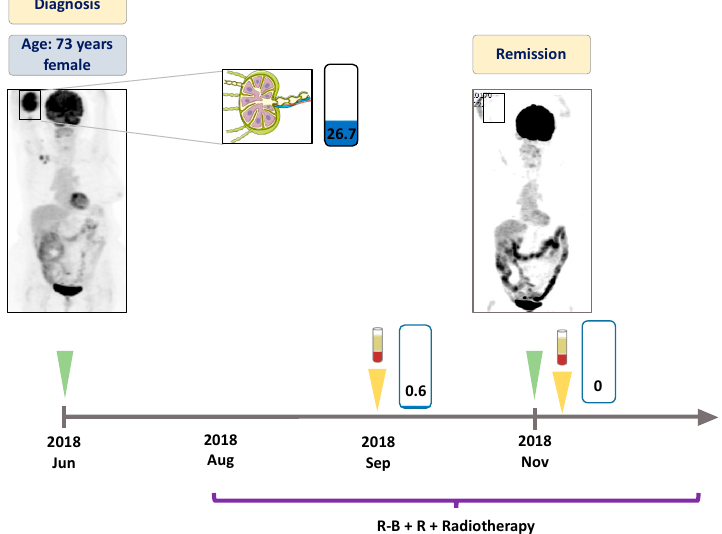
Figure 4. Detailed illustration of treatment monitoring in Patient #4. Low variant allele frequency of EZH2 Y646F mutation was found in the plasma after one week of treatment initiation. End of treatment ctDNA at three months was found to be EZH2 wild type, with the corresponding PET-CT revealing complete metabolic response of the disease. Since then the patient has received rituximab maintenance therapy with good general health conditions. Numbers in the rectangles represent the VAF of the mutation, blue color indicates the Y646F variant. Green arrows indicate the time when the PET scans were performed, yellow arrows indicate the time when liquid biopsy specimens were collected. R-B + R: rituximab, bendamustin plus maintenance rituximab.